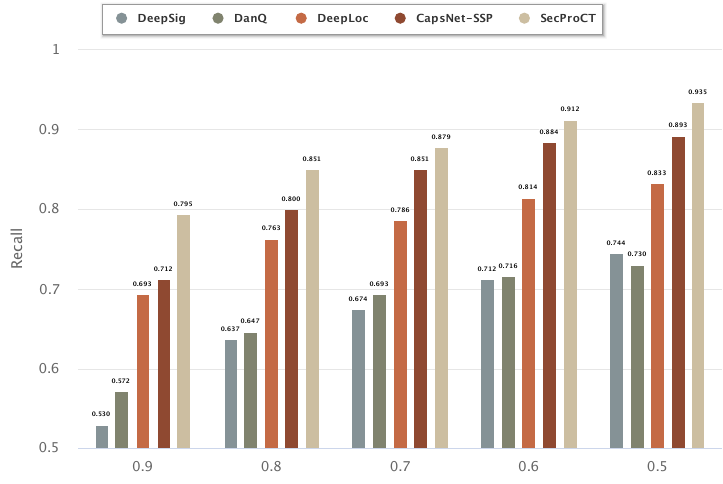
Figure 2. Prediction results of known saliva-secretory proteins.